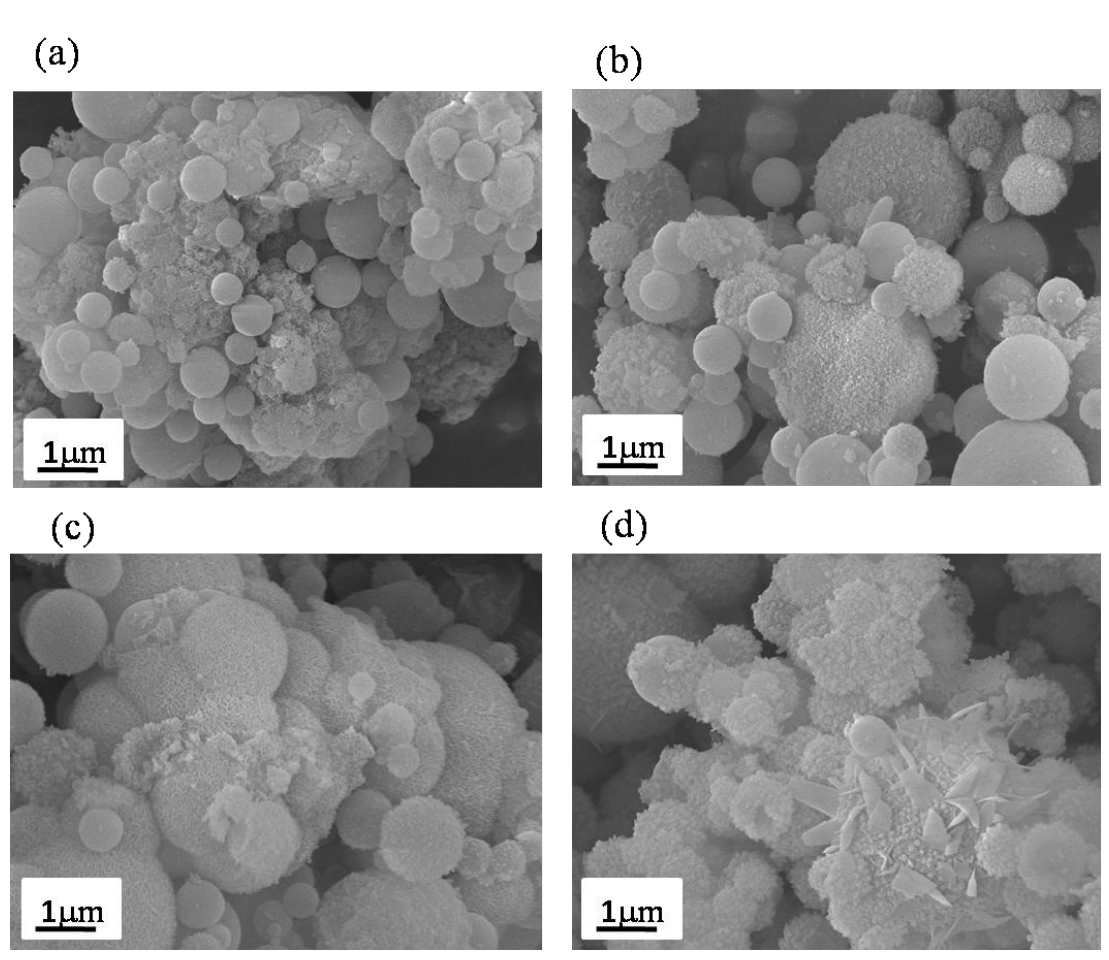
Figure 5. SEM images of ( a ) un-treated BG particles and ( b ) 0.1 M, ( c ) 0.3 M, and ( d ) 0.5 M PEG- treated BG powders after being immersed in SBF for one day. BG powders after being immersed in SBF for one